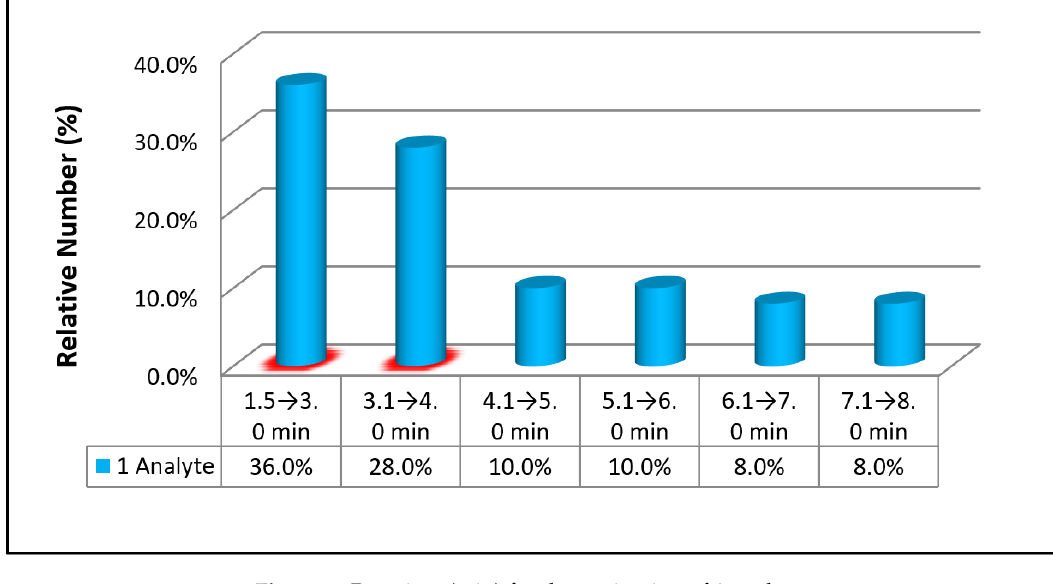
Figure 3. Run time (min) for determination of 1 analyte.